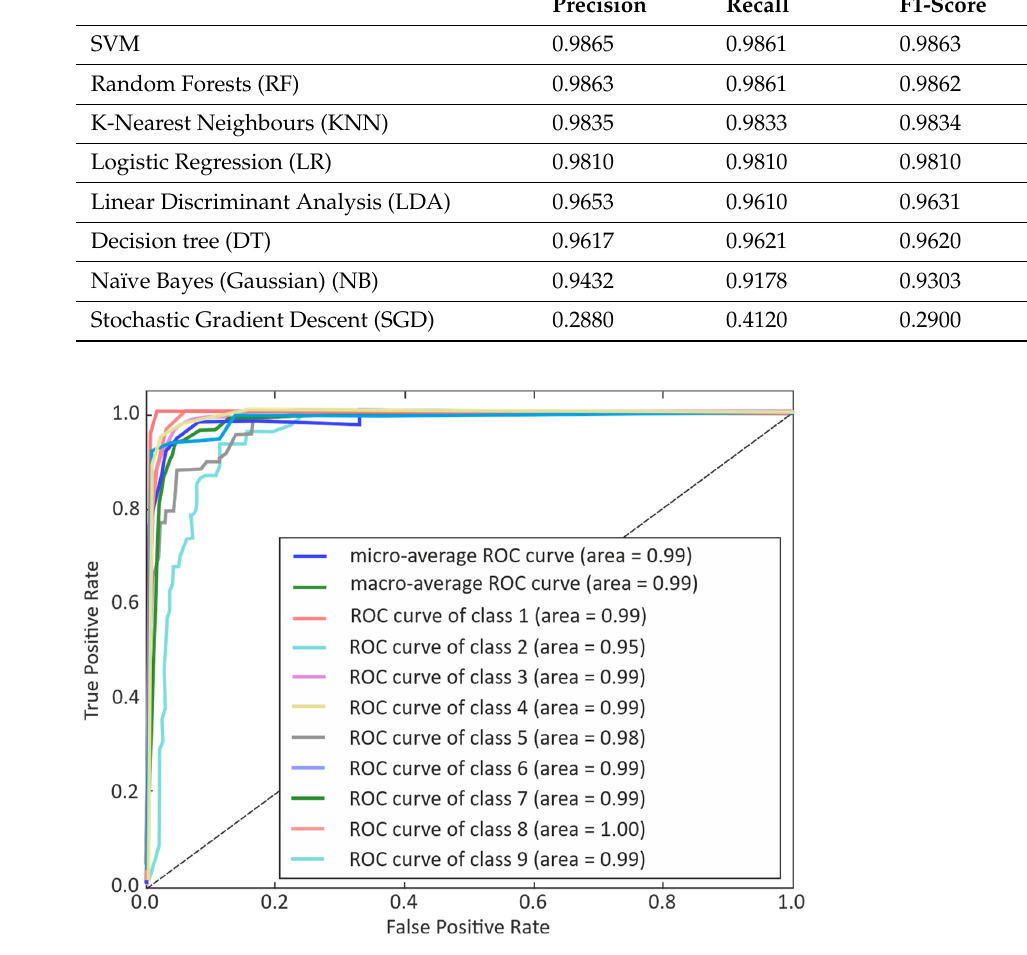
Figure 3. ROC plot for SVM classifier (micro-averaged 99%).